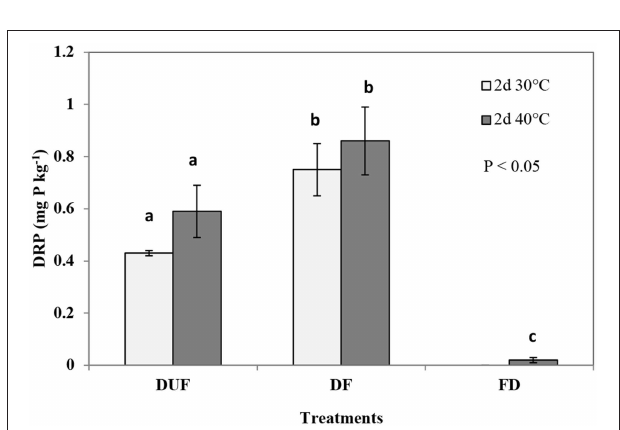
FIGURE 2 | Comparing DRP (mg P kg − 1 ) leached in 2-days drying, unfumigated (DUF), with drying followed by fumigation (DF), and fumigation followed by drying (FD) treatments. Error bars represent standard deviation (for some columns error bars are too small to be seen), n = 3. Means with the same letter are not significantly different from each other at the significance level of P < 0.05 as determined using Tukey’s post-hoc test.